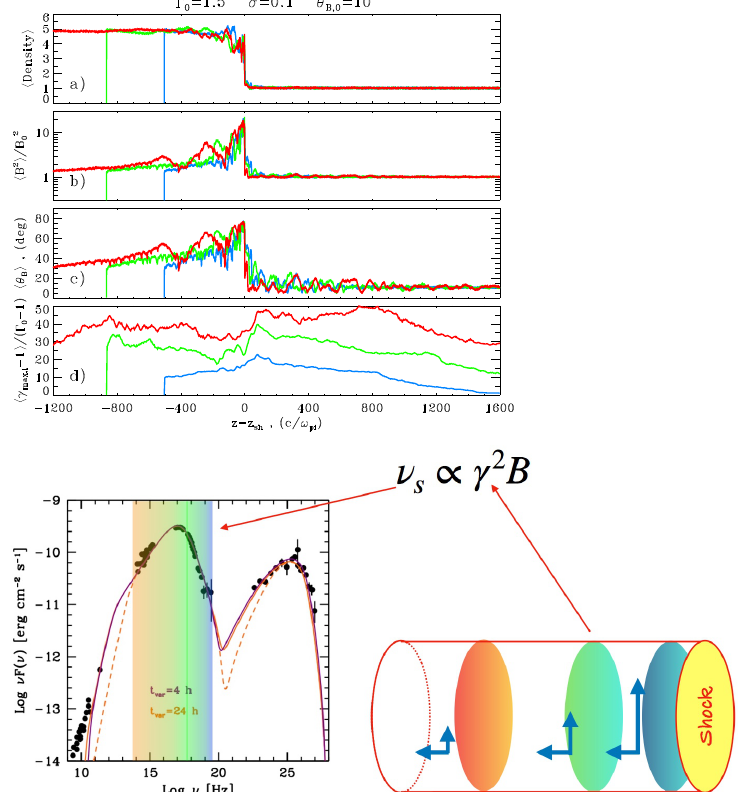
Figure 3. ( Upper panel a – d ) The results of a PIC simulations of a parallel, mildly relativistic, low magnetization shock. The panel reports (top to bottom) the spatial profile of density, magnetic energy normalized to that carried by the upstream flow, average angle between the magnetic field and the shock normal and average Lorentz factor of the accelerated electrons. The second panel clearly shows the generation of a strong magnetic field at the shock parallel to the front (third panel). From [54]. Reproduced with kind permission from Oxford University Press and the Royal Astronomical Society. ( Lower panel ) Cartoon of the model, bei g inspired by PIC simulations, assumed to calculate the expected polarization for the shock scenario. Electrons that are accelerated at the shock (right) are advected downstream and cool through synchrotron and SSC emission. Electrons emitting in the X-ray band (blue), which have a quite limited lifetime, emit very close to the shock front, where the magnetic field is dominated by the self-generated component parallel to the shock (blue arrows). Being produced in a region with a well defined direction of the field, the synchrotron emission from these electrons is highly polarized. Electrons with lower energy (green and orange) produce synchrotron radiation at a lower frequency (UV, optical) and, because of the longer cooling timescale, can propagate at distances where the self-generated field decays below the field carried by the flow, which are assumed to be nearly perpendicular to the shock. The integrated emission from these low energy electrons originates in a region in which the two (orthogonal) components of the field are, on average, comparable, which leads to a low degree of